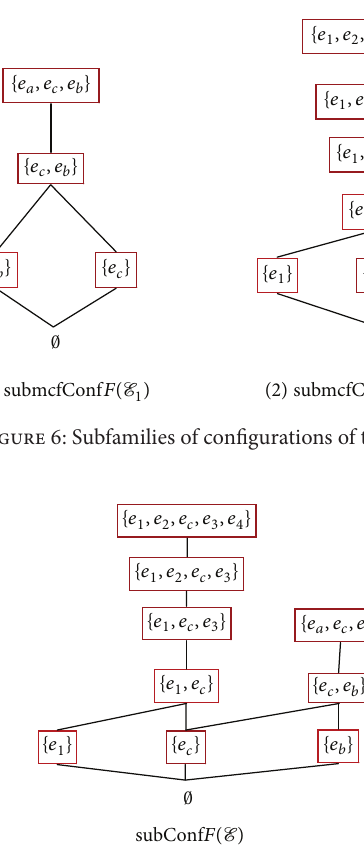
Figure 7: Subfamily of configurations of the